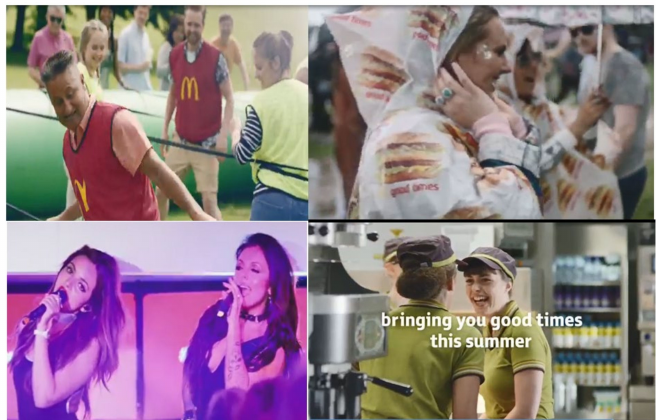
Figure 1. Stills from McDonald’s ‘ Summer of Good Times ’ advert (from https: // www.youtube.com / watch? v = EfU-NV1H8FQ).